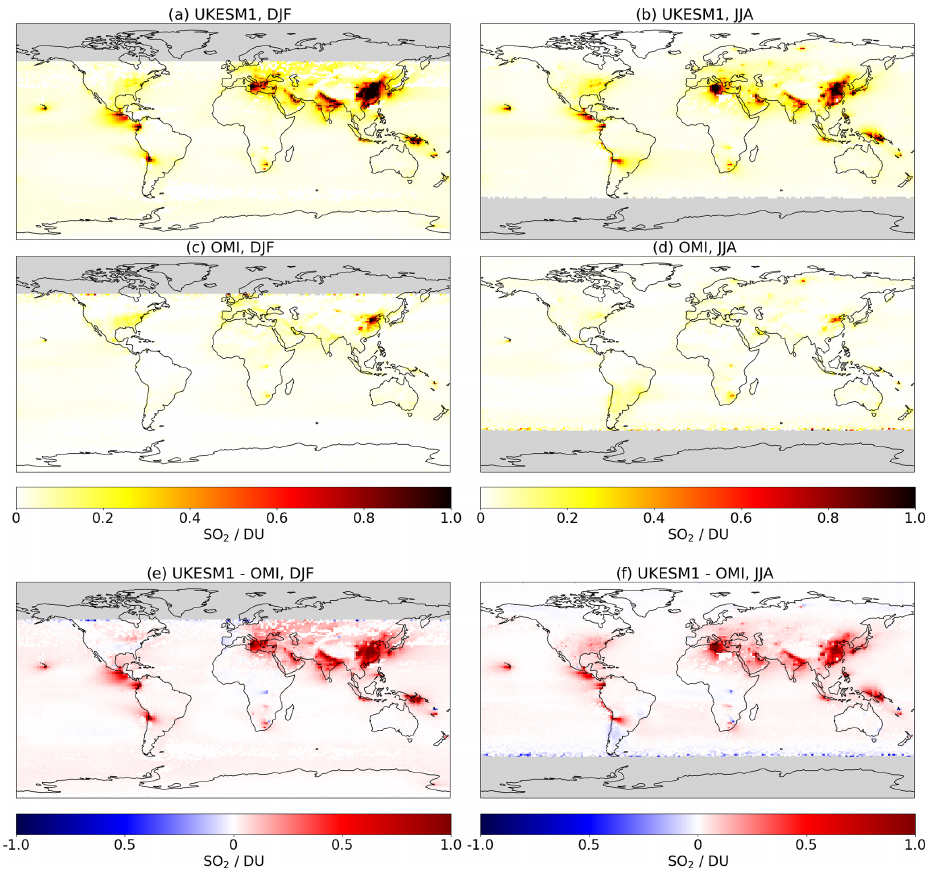
Figure 8. Total column SO 2 for UKESM1 (a, b) , OMI (c, d) , and UKESM1 – OMI (e, f) . DJF is shown in the left column and JJA is shown in the right column. Median total column SO 2 in Dobson units is calculated for the period